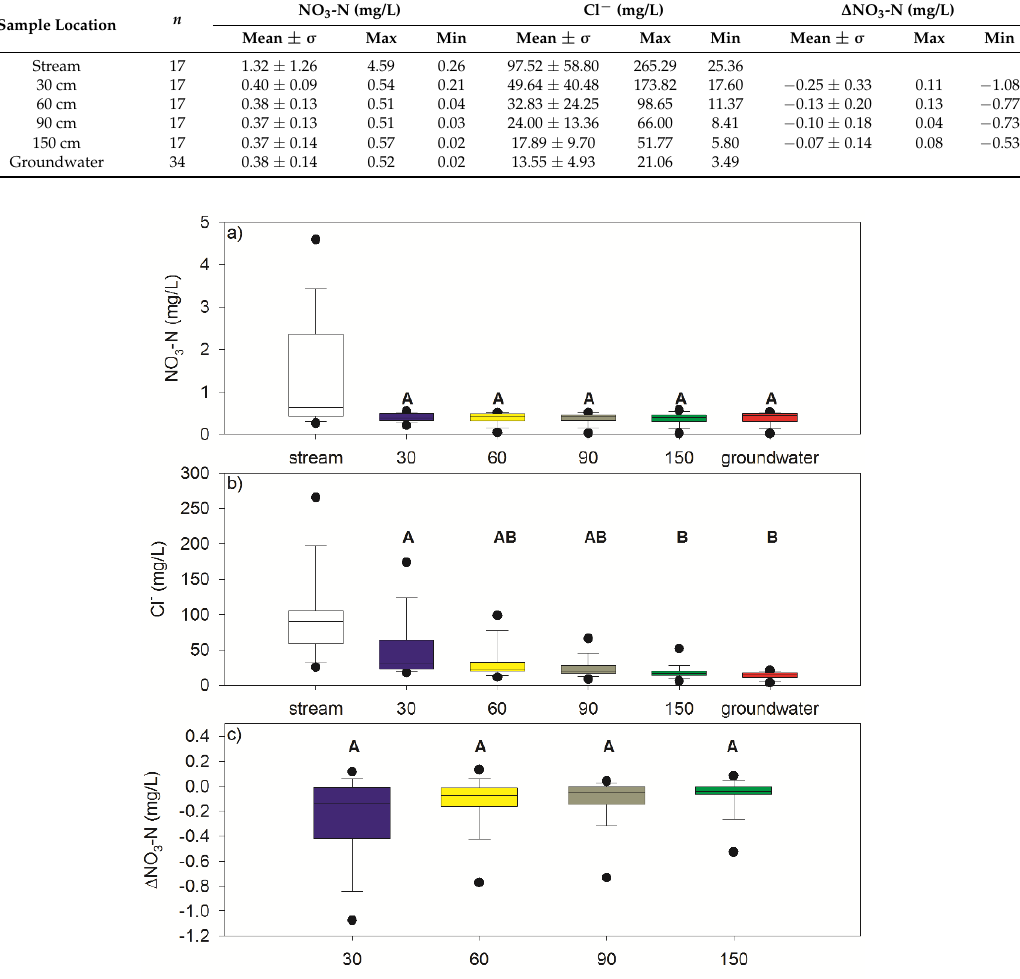
Table 1. Descriptive statistics of the seasonal nitrate as nitrogen and chloride concentration data for the water samples.